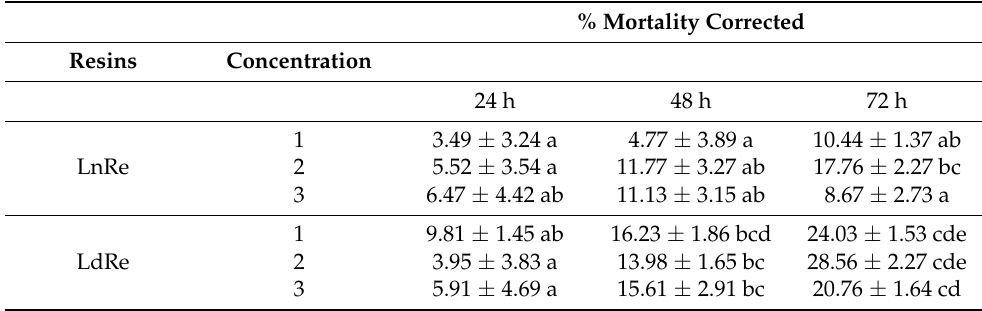
Table 3. Nematicidal activity of LnRe and LdRe resins againstJ2 M. incognita .